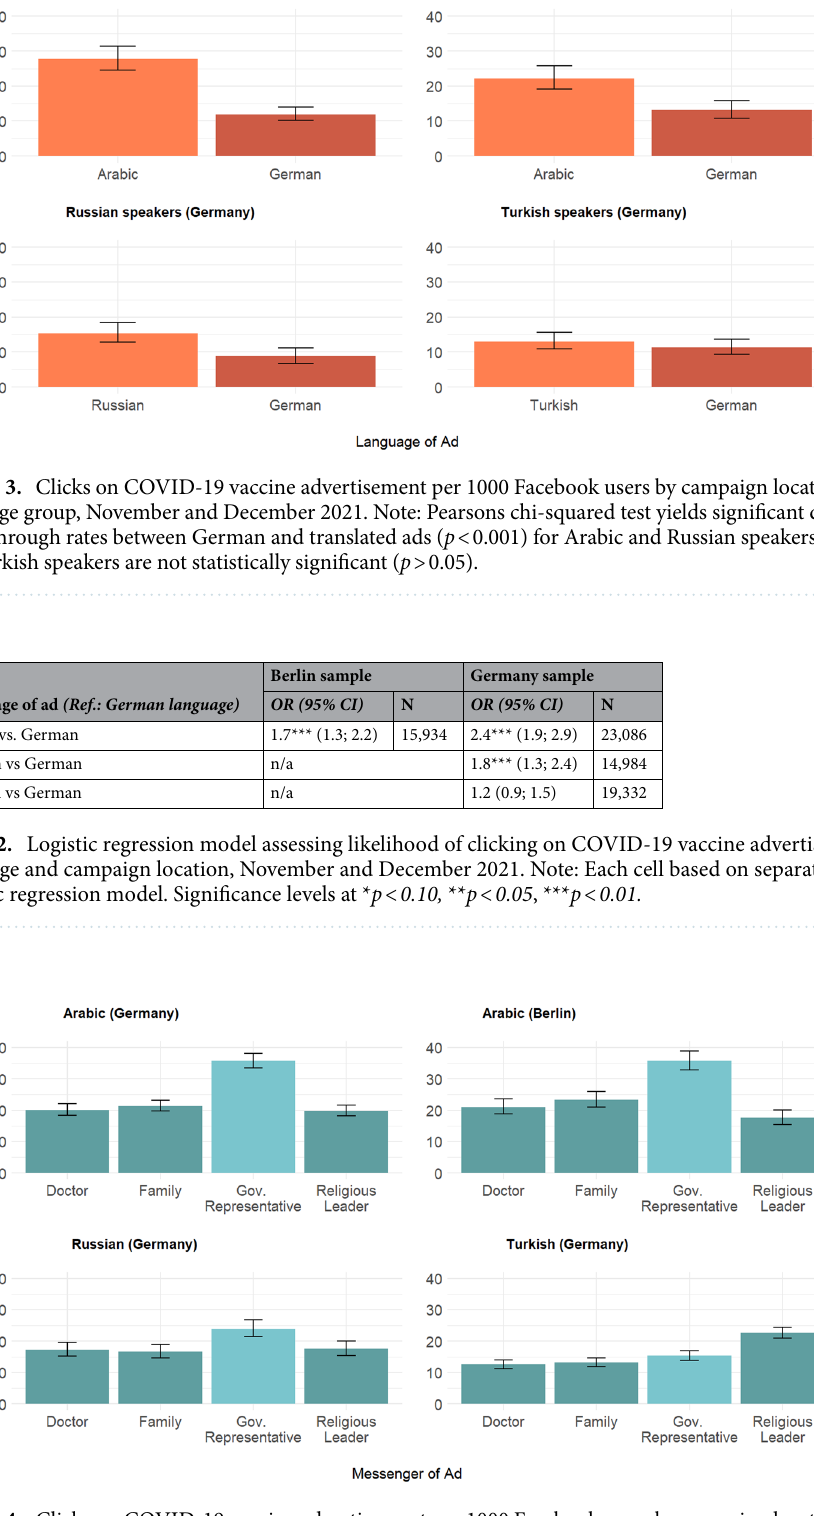
Figure 4. Clicks on COVID-19 vaccine advertisement per 1000 Facebook users by campaign location and image, November and December 2021. Note: Pearsons chi-squared test yields significant differences in click-through rates between government representatives and all other messengers (p < 0.001) among Arabic and Russian speakers. Among Turkish speakers, differences between religious leaders and all other groups is statistically significant at p <